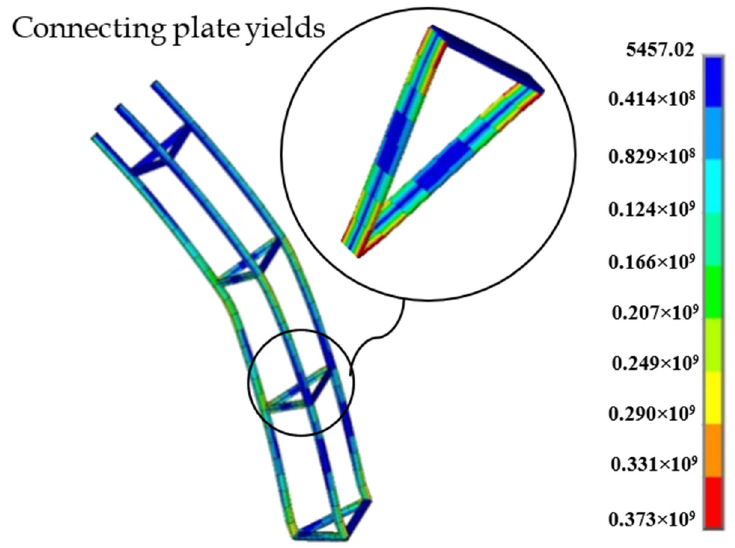
Figure 23. Global stress distribution of chord and connecting plate combined failure (Pa).